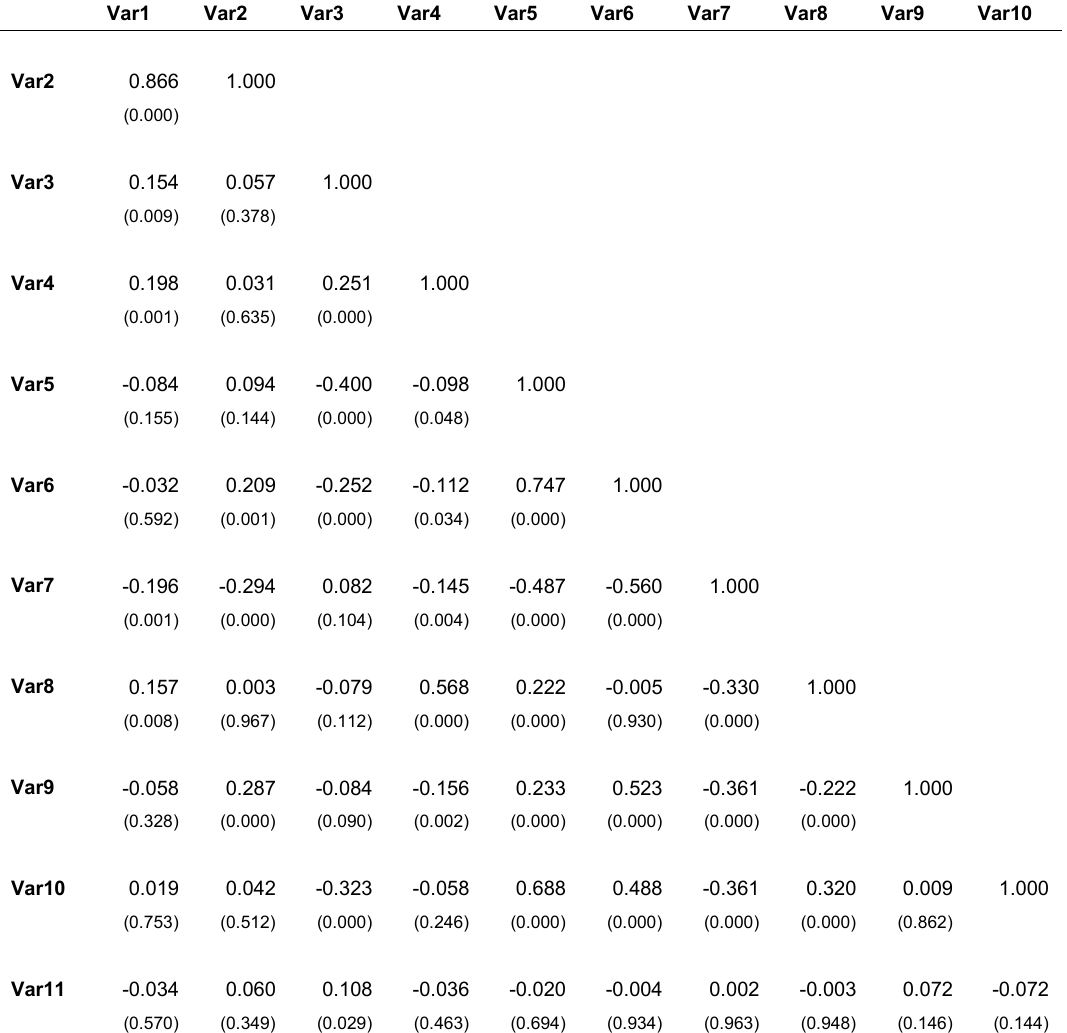
Table A2 . Correlation Matrix for Variables of Models 2, 3, 5, and